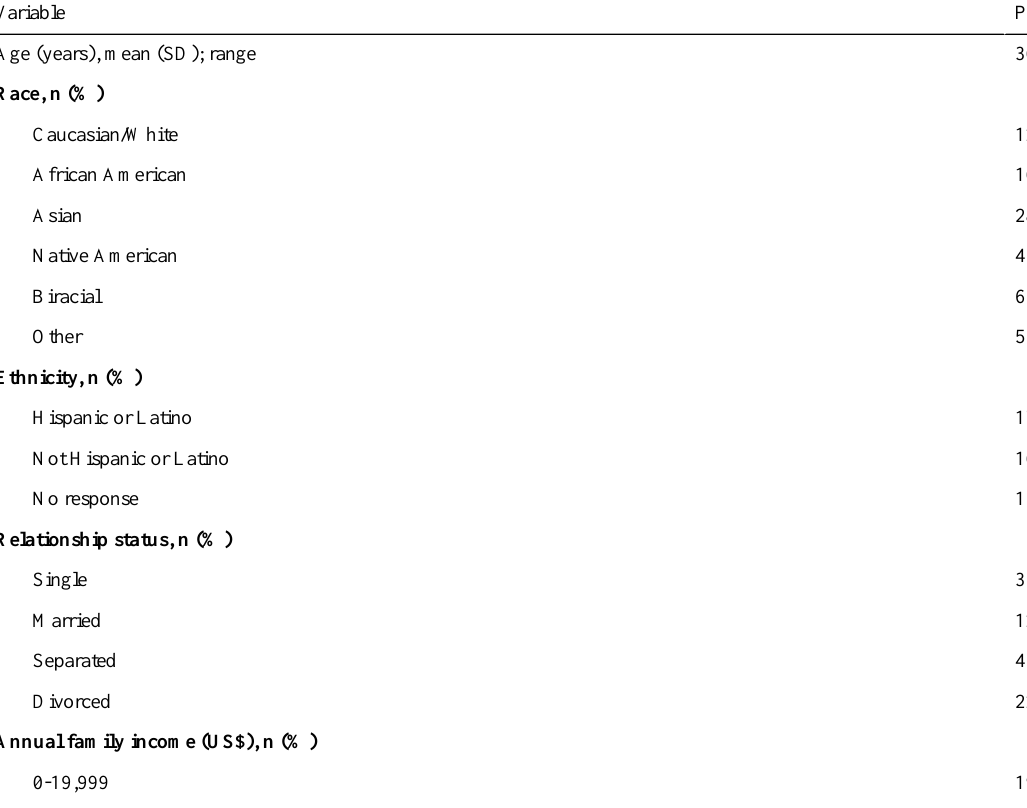
Table 1. Demographics of participants